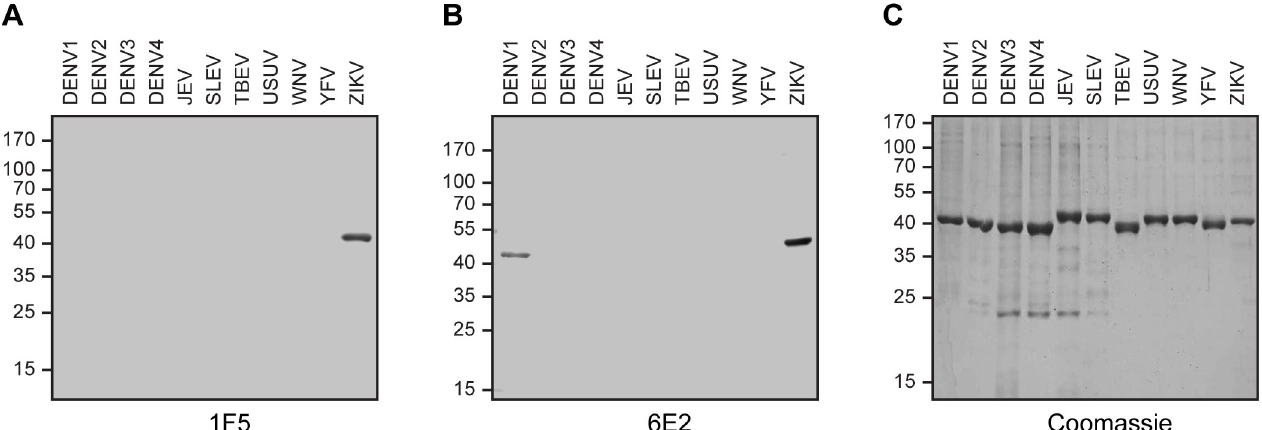
Fig 2. Western blot analysis of flavivirus recombinant NS1 proteins with 1F5 and 6E2 mAbs. SDS-PAGE analysis of E . coli -expressed DENV1-4, JEV, SLEV, TBEV, USUV, WNV, YFV and ZIKV recombinant NS1 protein samples analyzed by immunoblot using (A) 1F5 or (B) 6E2 mAbs, or by (C) Coomassie brilliant blue staining. The position of the molecular mass standards is indicated on the left.